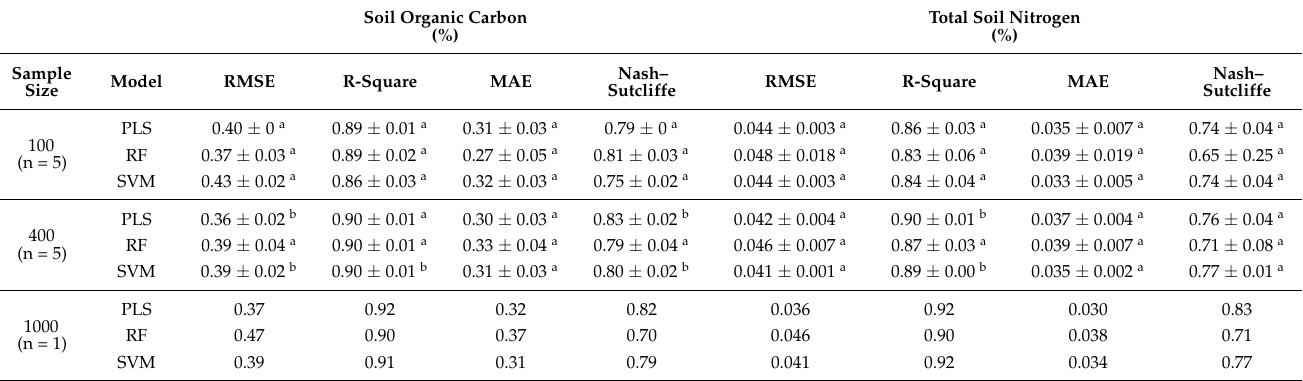
Table 2. Mean and standard deviation of performance metric in terms of average root mean square error (RMSE), coefficient of determination (R-square), mean annual error (MAE) and Nash–Sutcliffe coefficient as a function of sample size using partial least squares (PLS), random forest (RF) and support vector machine (SVM) models based on five replicates randomly selected of each sample size. For each method, five calibrations were built for each sample size. The entire dataset included 1000